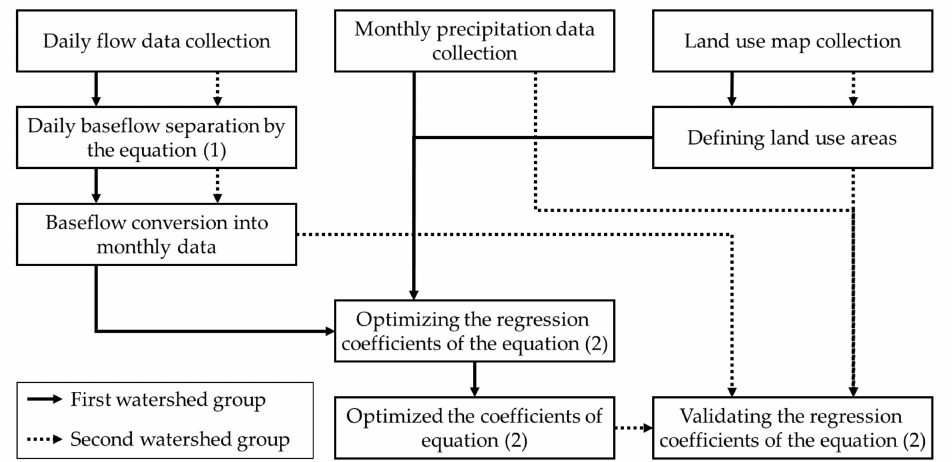
Figure 2. Schematic flow of the